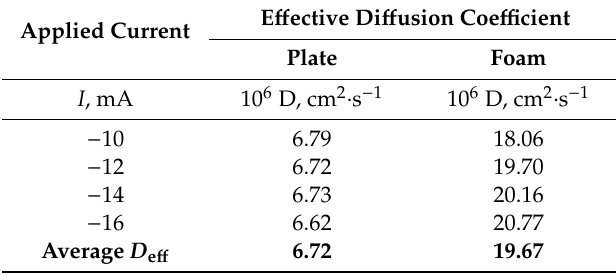
Table 4. E ff ects of electrode geometry on e ff ective Cu(II) ions di ff usion coe ffi Table 4. Effects of electrode geometry on effective Cu(II) ions diffusion coefficient.